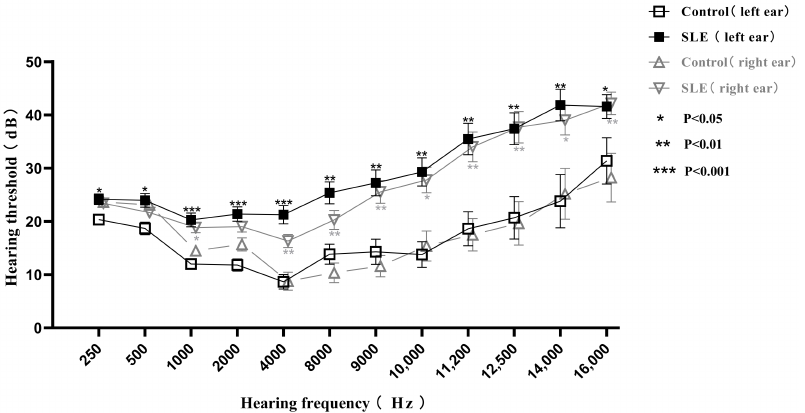
Figure 1. Comparison of pure tone audiometry and extended high frequency audiometry thresholds from 250 to 16,000 Hz frequencies between 91 SLE patients and 30 healthy controls. Data are presented as mean ± SEM and the mean values at each hearing frequency are linked by the trend line. * p < 0.05, ** p < 0.01, *** p < 0.001 by t